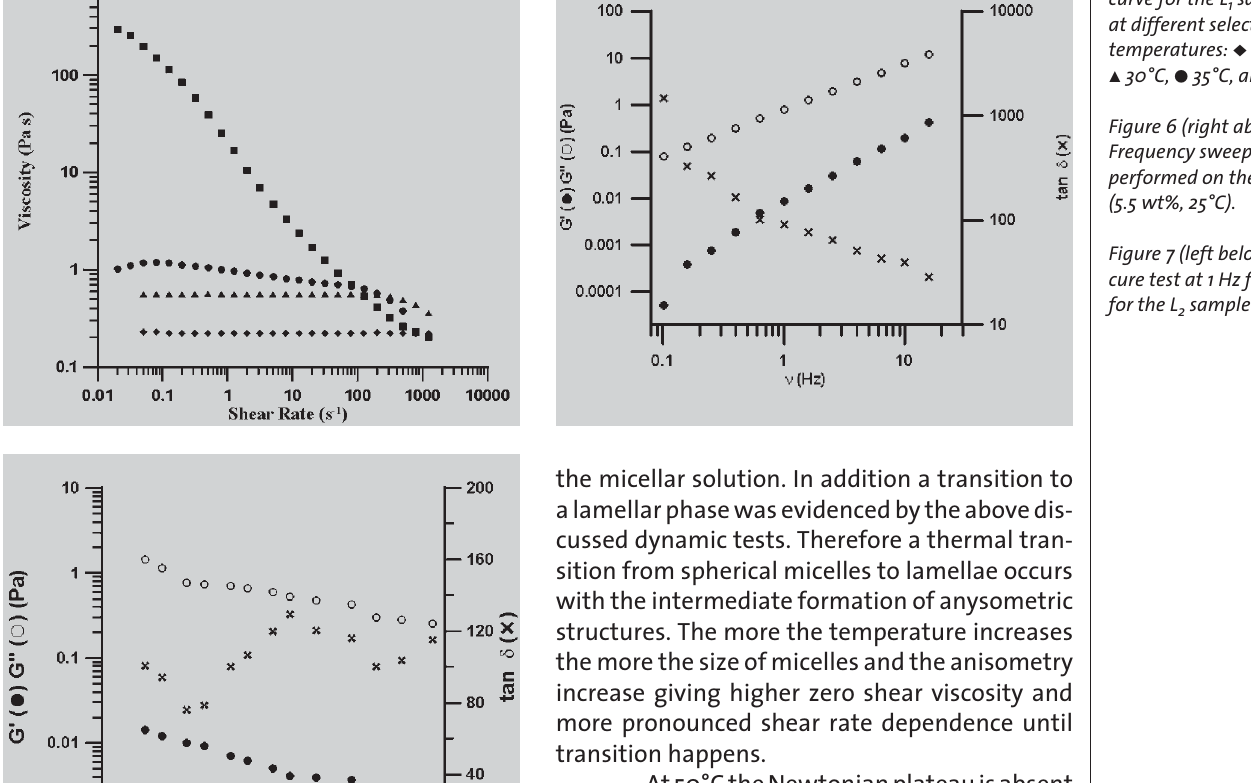
Figure 5 (left above): Flow curve for the L 1 sample at different selected temperatures: Ï 25°C, Ú 30°C, Ê 35°C, and ‡ 50°C. Figure 6 (right above): Frequency sweep tests performed on the L 2 sample (5.5 wt%, 25°C). Figure 7 (left below): Time cure test at 1 Hz frequency for the L 2 sample (5.5